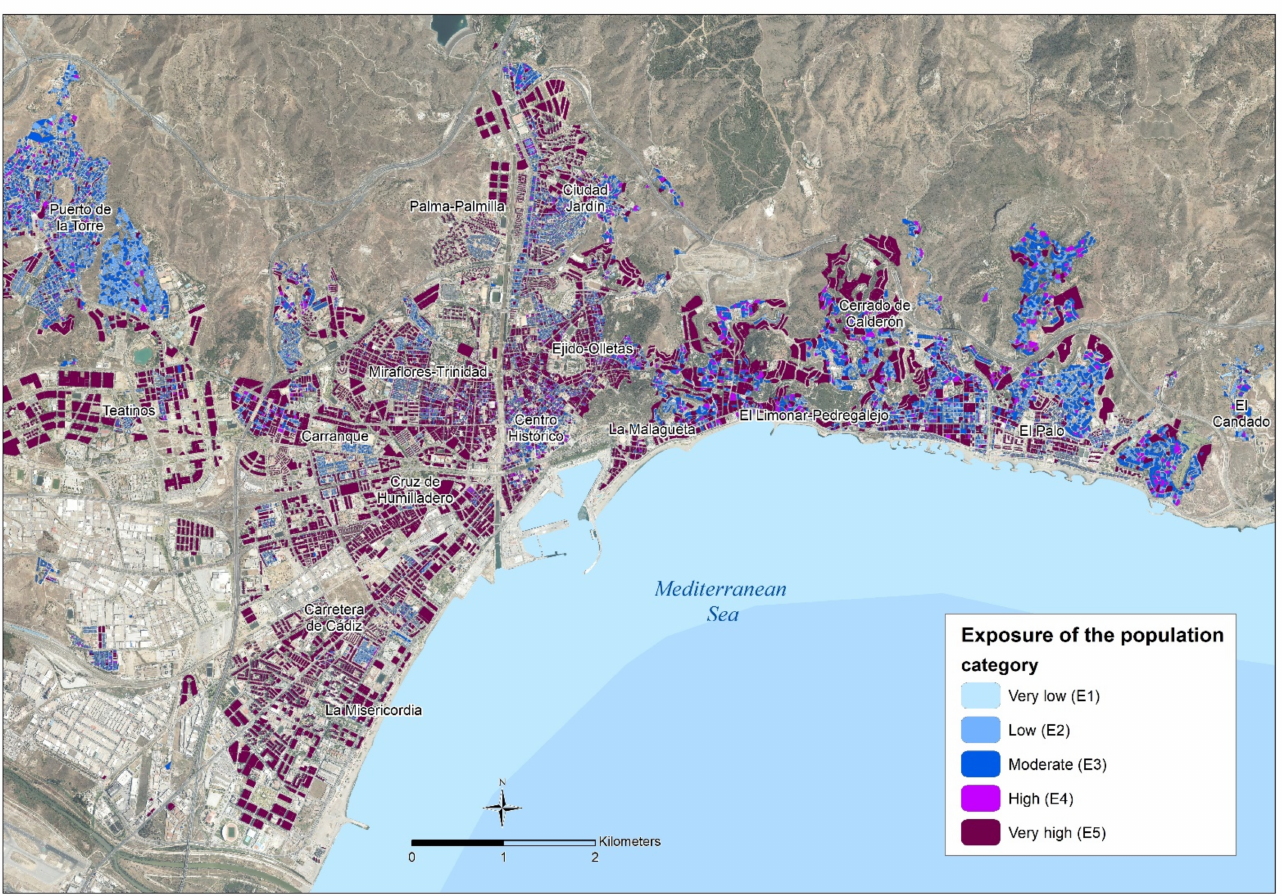
Figure 8. Population exposure to contagion hazard: map of population. Own